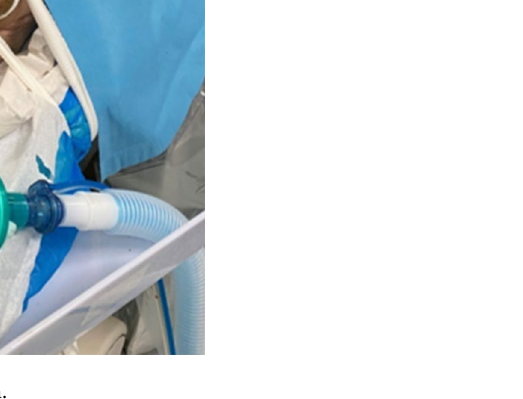
Figure 1. Intubated pig in supine